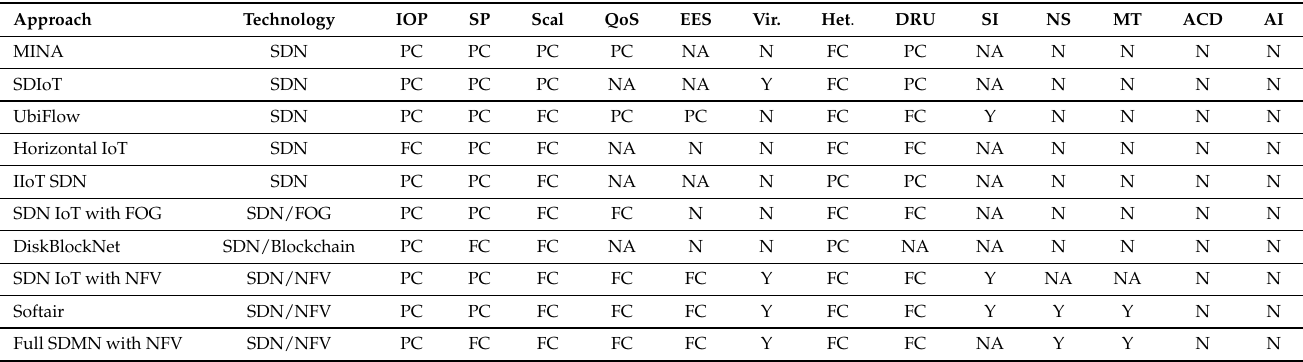
Table 2. SDN/NFV Based IoT Approaches.